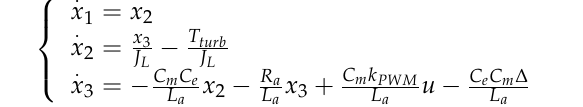
Figure 3. Block diagram of the RSSSP tracking loop.